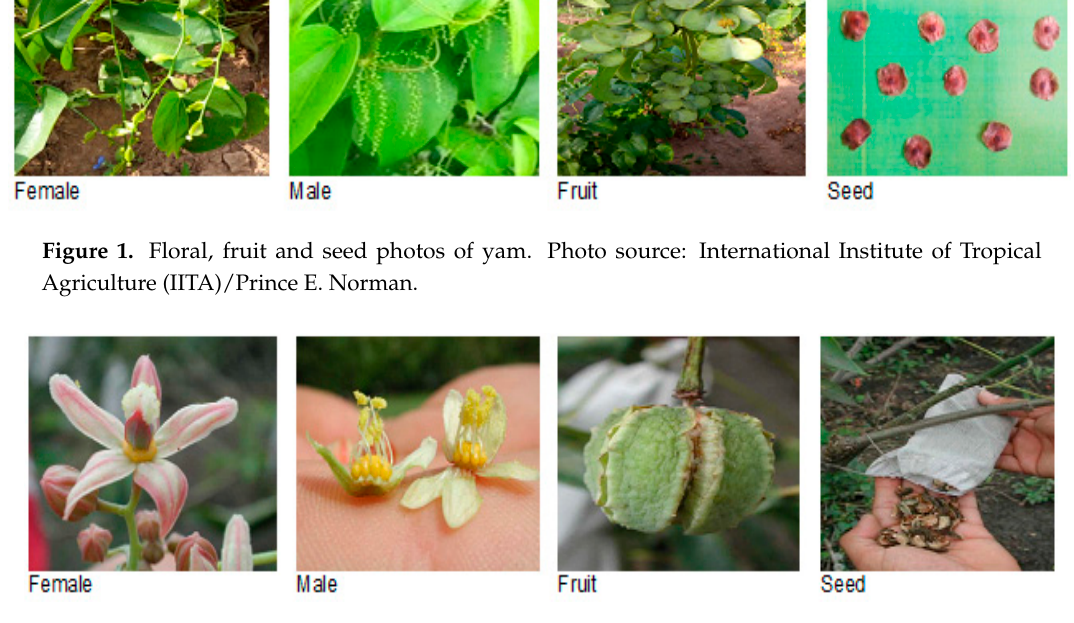
Figure 2. Floral, fruit and seed photos of cassava. Photo source: IITA/Prince E. Norman.